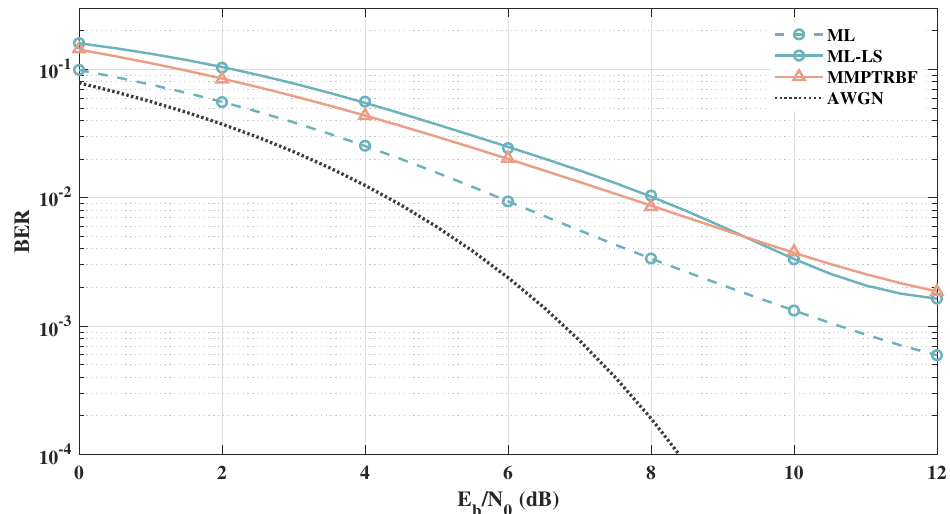
Figure 16. Systems with M T = 4 and M R = 1 antennas for 4-QAM modulation.